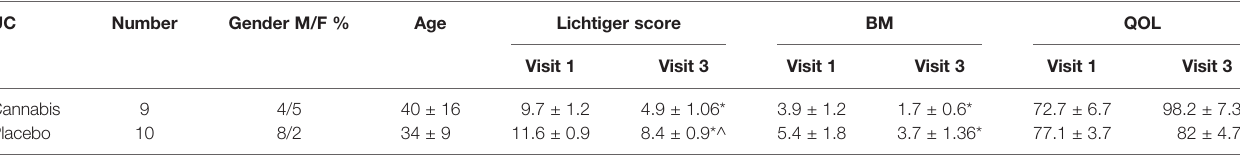
TABLE 3 | Clinical parameters of UC patients.